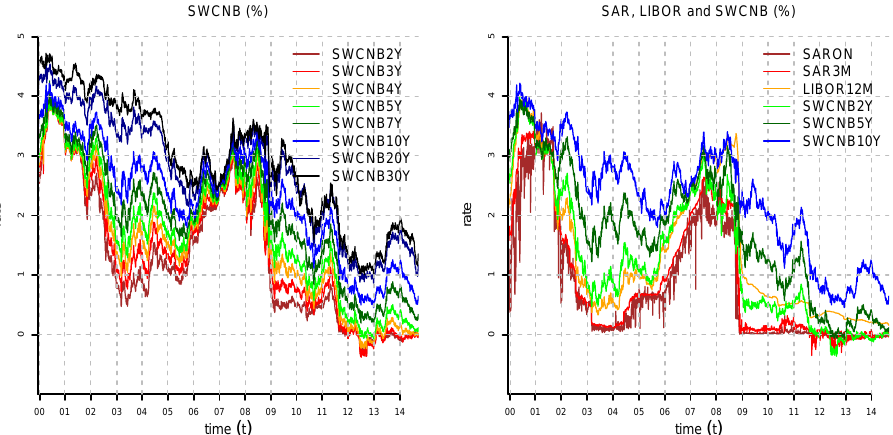
Figure 2. Yield rates: (lhs) Swiss Confederation Bond (SWCNB) and (rhs) a selection of SAR, LIBOR and Swiss Confederation Bond (SWCNB) from 8 December 1999, until 15 September 2014. Note that LIBOR looks rather differently from SAR and SWCNB after the financial crisis of 2008. Realised volatility (%)